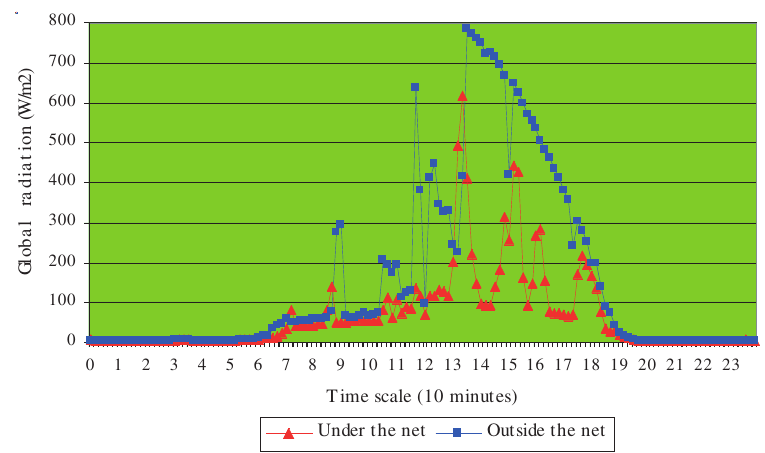
Figure 8. The mean daily course of global radiation under the hail net and outside of it on sunny days /Pallag 2011 June 1 – September 30/